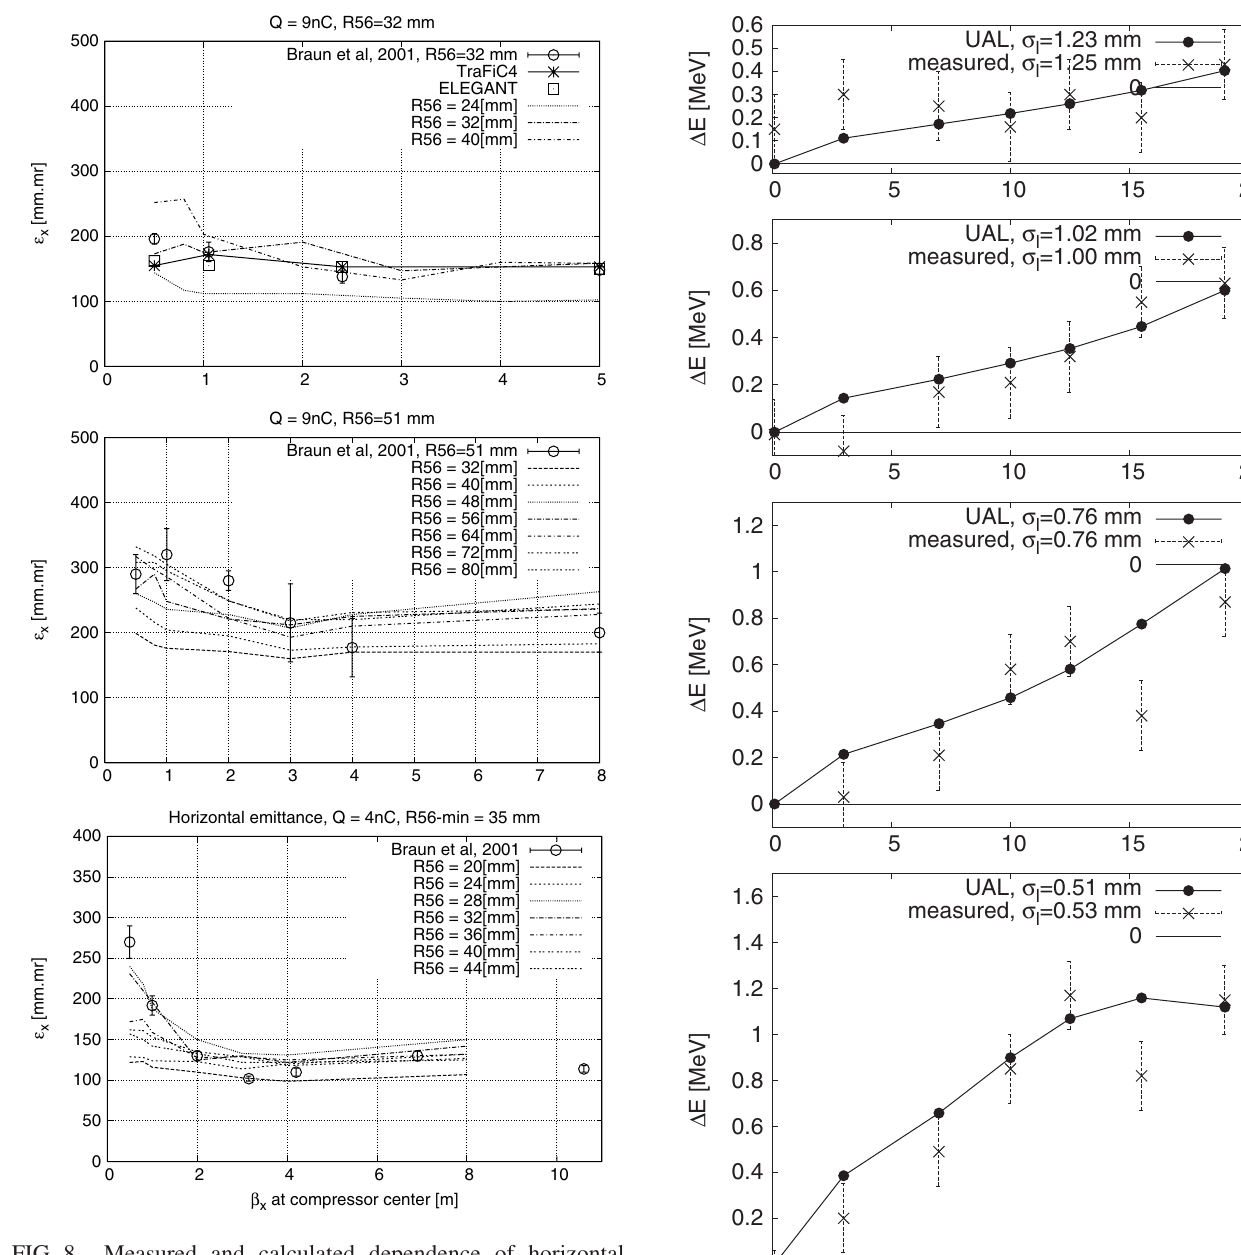
FIG. 8. Measured and calculated dependence of horizontal emittance on (cid:2) x at chicane center for three different parameter combinations. Open circles are measured values, smooth curves are UAL string calculations. TRAFIC4* and ELEGANT (upper graph only) simulations predict ‘‘no significant dependence on the beta function’’